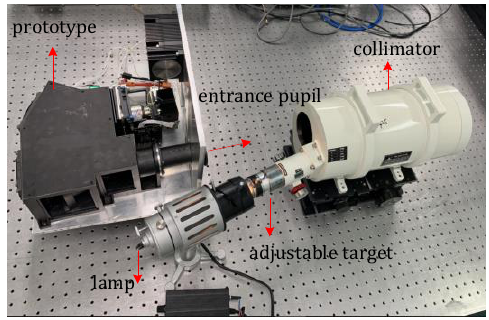
Figure 7. Experimental setup.